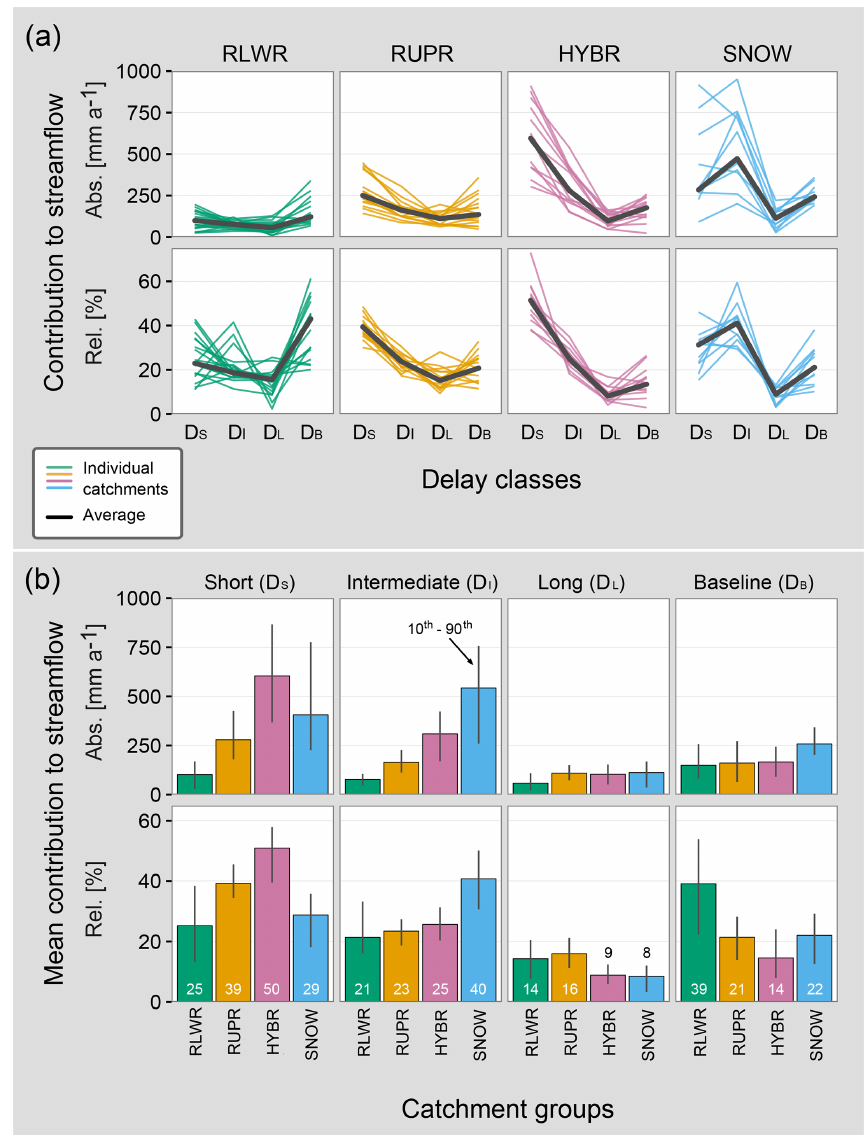
Figure 6. Delayed contributions (in absolute and relative terms) to streamflow according to (a) delay classes and (b) catchment groups. In (a) each coloured line intentionally represents one catchment to highlight the catchment-specific composition of different